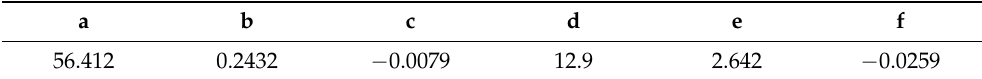
Table 2. Values of the equations describing the pump operating curves (determined in accordance with the methodology that is presented in